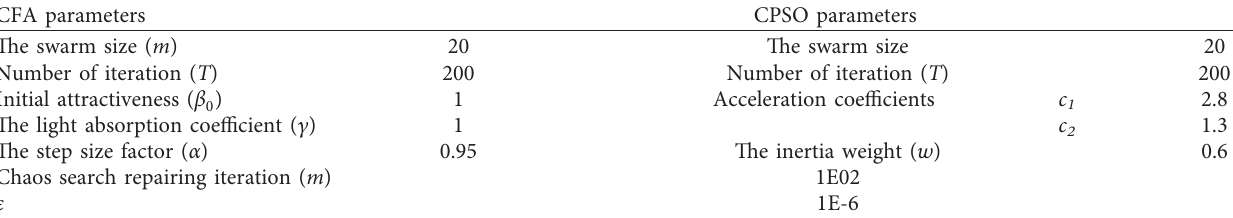
Table 1: The proposed algorithm parameters.